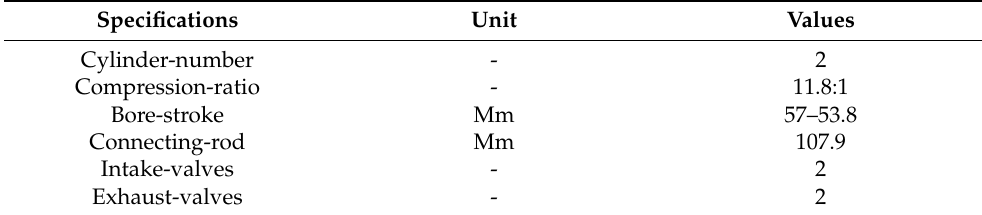
Table 1. The specifications of testing engine [14].